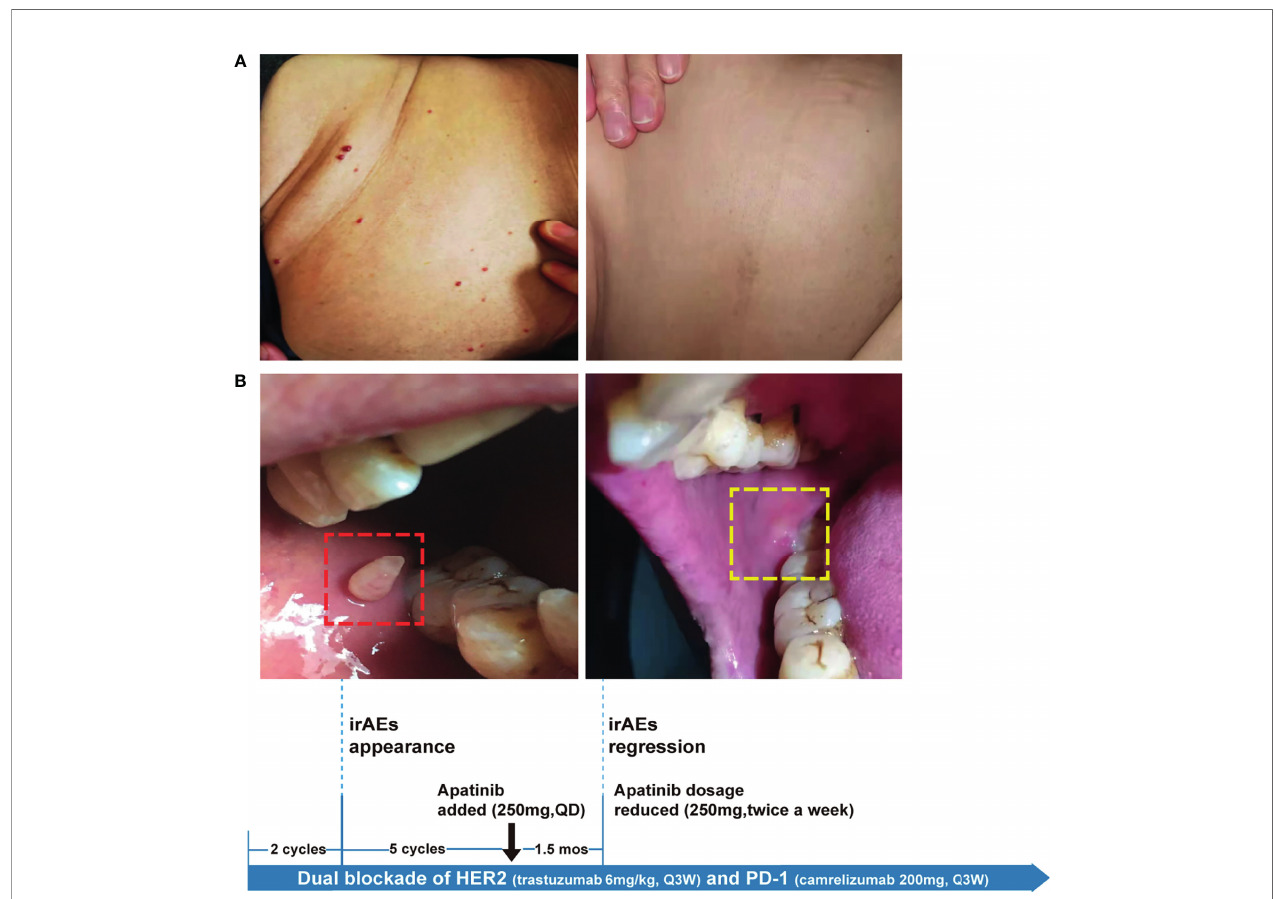
FIGURE 3 | The management of camrelizumab-related irAEs with anti-VEGF agent apatinib. Representative images showing irAEs of (A) RCCEP, (B) mucosal membrane and their resolution after apatinib treatment. irAE, immune-related adverse event; RCCEP, reactive cutaneous capillary endothelial